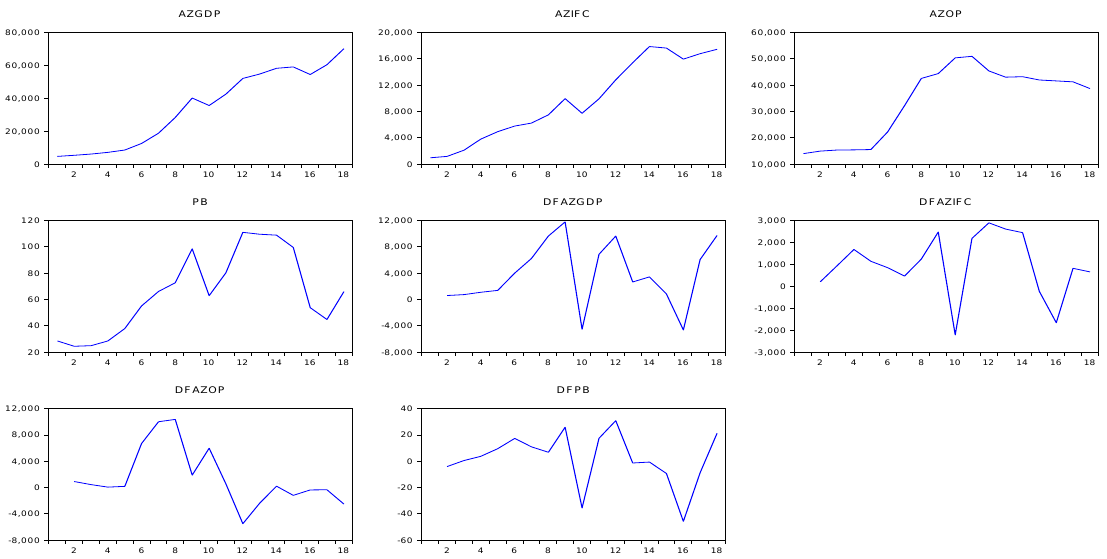
Figure A2. World GDP, industrial production, daily oil production, daily oil consumption and oil prices.